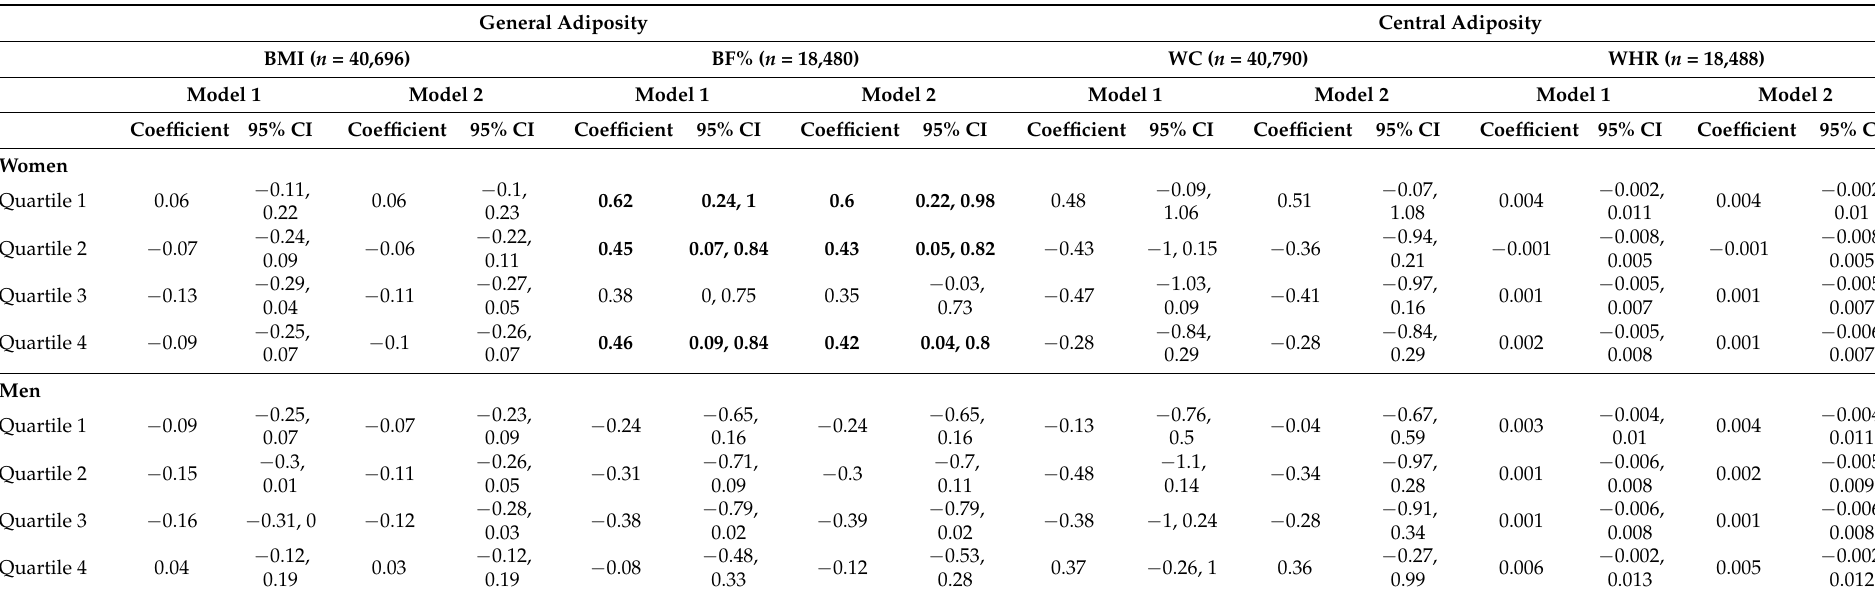
Table 2. Longitudinal associations between baseline alcohol consumption and adiposity at follow-up in the UK Biobank. General